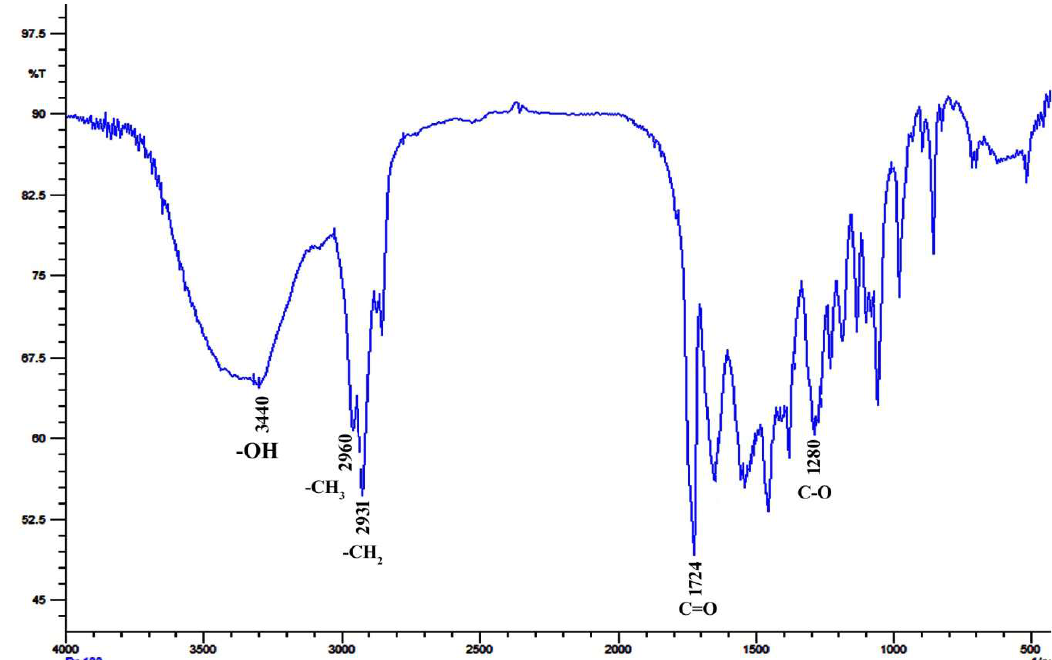
Figure 11. Fourier-transform infrared spectrum of PHB extracted from E. aquimaris . The absorption bands at 3440, 2960, 2932, 1724, and 1280 cm − 1 corresponding to OH, CH 3 , CH 2 , C = O, and C–O groups.